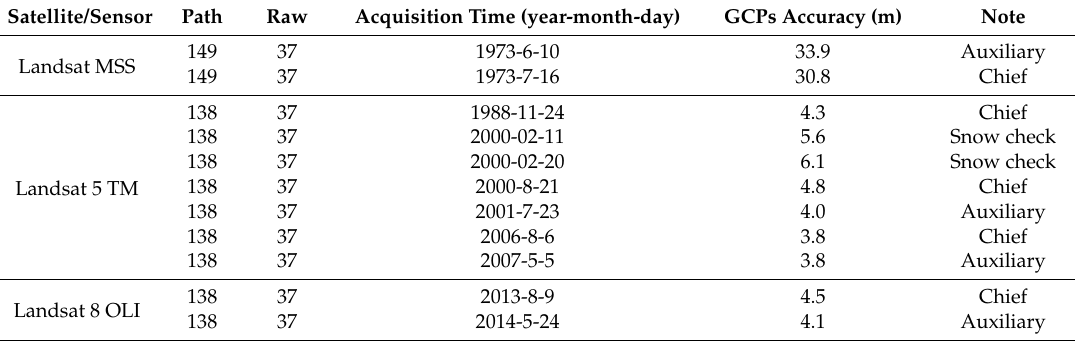
Table 1. Multi-temporal remote sensing images of glaciers on Geladandong